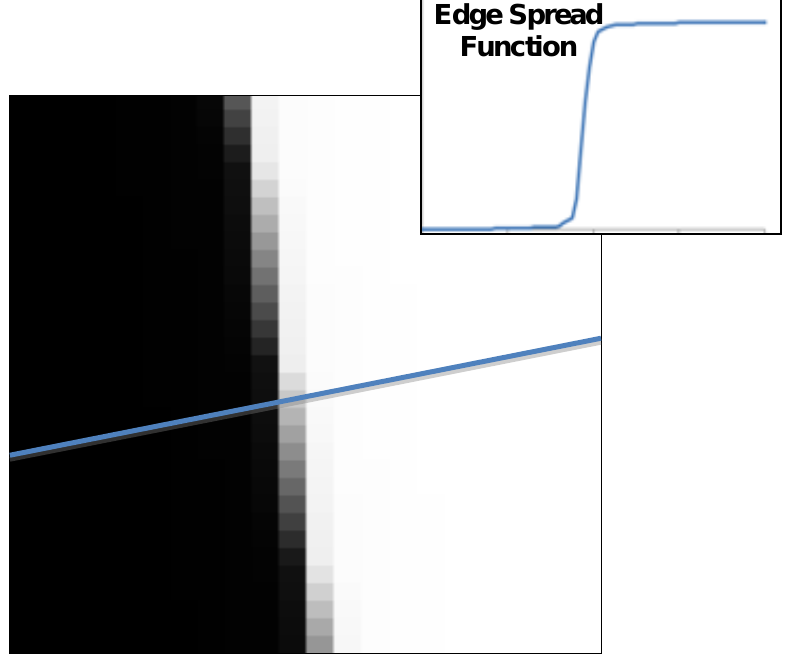
Figure 5. Illustration of an edge spread function (ESF) calculated with the TIRS instrument when observing an edge transition between low and high radiance targets. The blue line illustrates the perpendicular to the edge that was used to calculate the edge spread function. Edge Spread